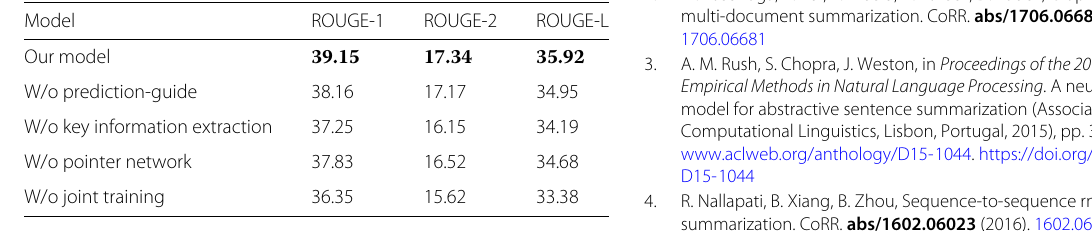
Table 2 Ablation studies of our model on the test